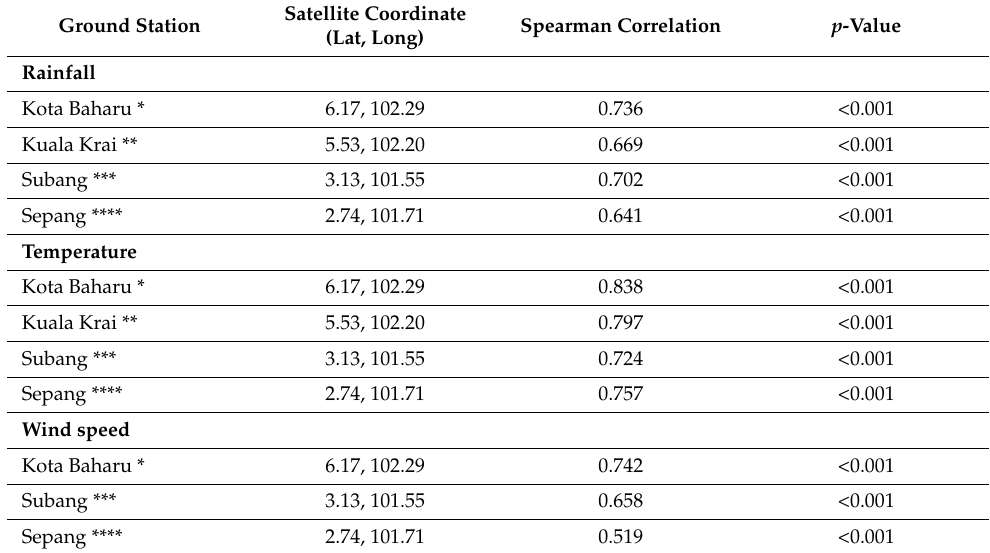
Table 2. Correlation between rainfall, temperature and wind speed data from EO and ground-based stations ( n = 4), Malaysia (2011 to